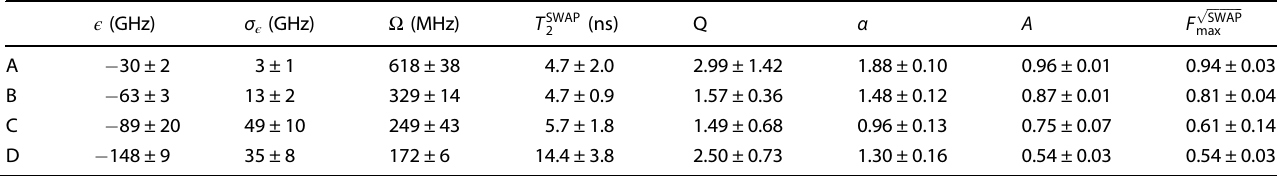
Table 1. Summary of experimental parameters extracted at various detuning positions from two-qubit experiments using donor atom qubits in